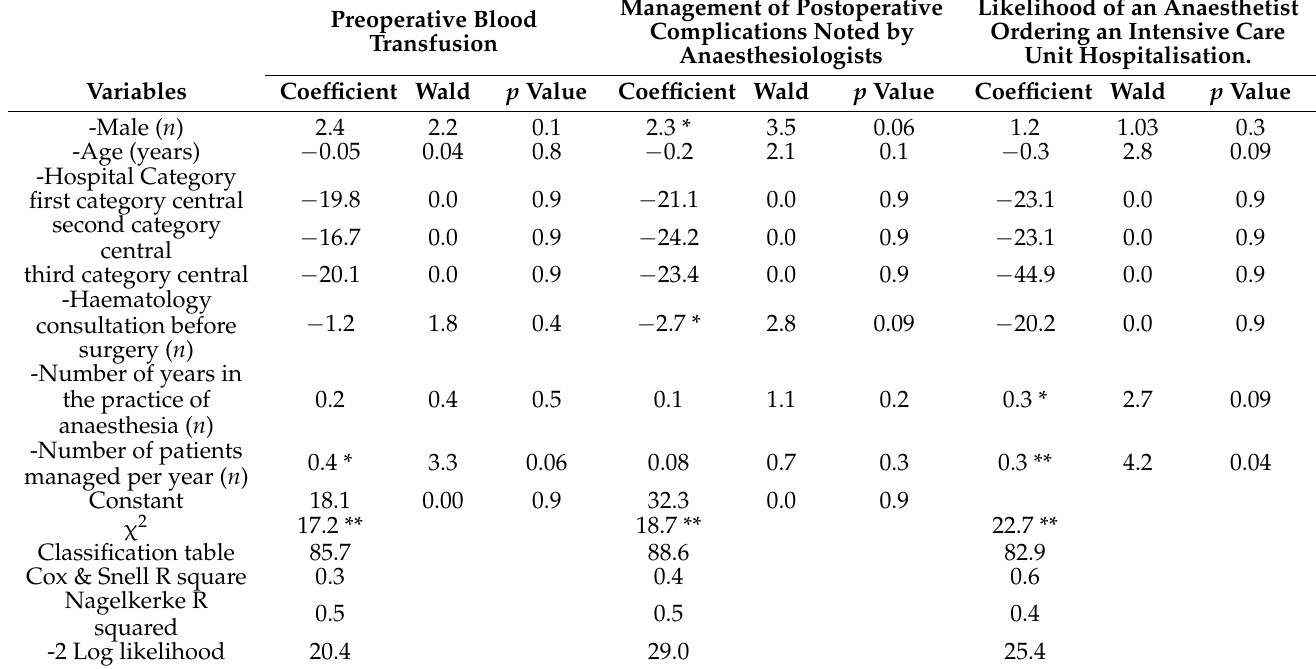
Table 4. Factors influencing preoperative blood transfusion, management of postoperative complications, and need for ICU hospitalisation after